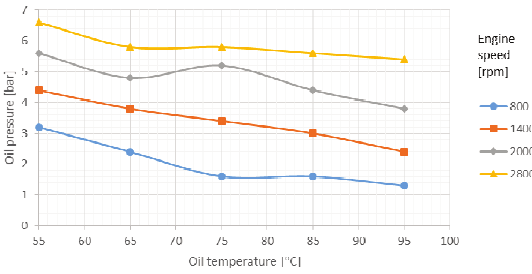
Fig. 16. The oil pressure as a function of oil temperature for different